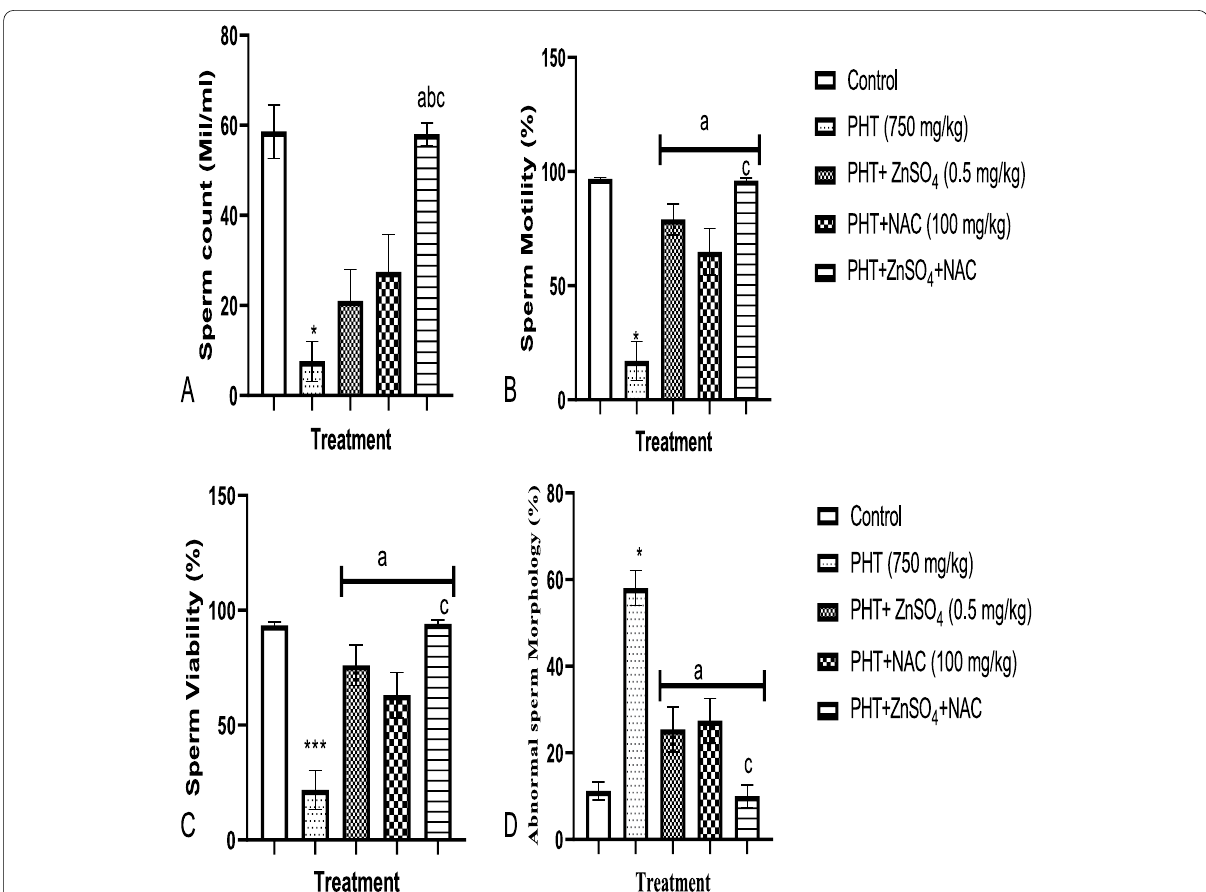
Fig. 2 Effects of treatment with zinc sulfate and N‑acetylcysteine on semen parameters of phthalate‑treated male Wistar rats. Values are expressed as mean SEM ( n 5) (one‑way ANOVA followed by Tukey’s post hoc test ). PHT phthalate, ZnSO 4 zinc sulfate, NAC N‑acetylcysteine. *, *** p < 0.05 ± = and p < 0.001 were considered statistically significant when compared with the control, while a , b , and c p < 0.05 were statistically significant when compared with PHT‑, PHT ZnSO 4 ‑, and PHT NAC‑treated groups + +